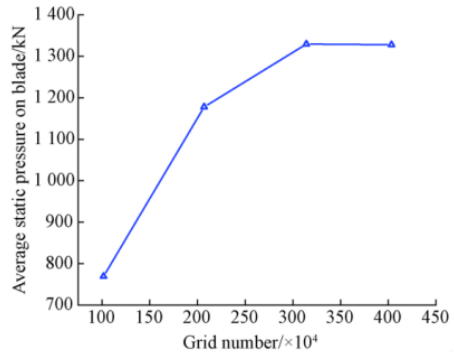
Figure 2. Grid independence